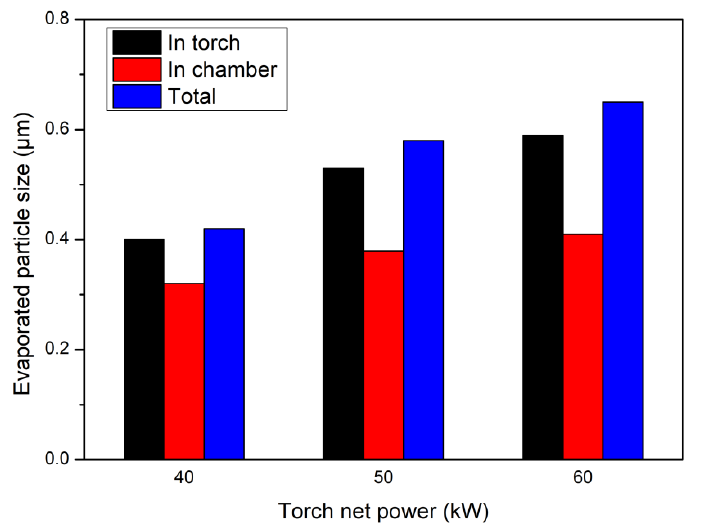
Figure 10. Effect of the torch net power on the size of the fully evaporated YSZ particles in the torch, free jet and in total. 40 SLPM of argon, 8 SLPM of hydrogen, chamber pressure: 100 Pa.